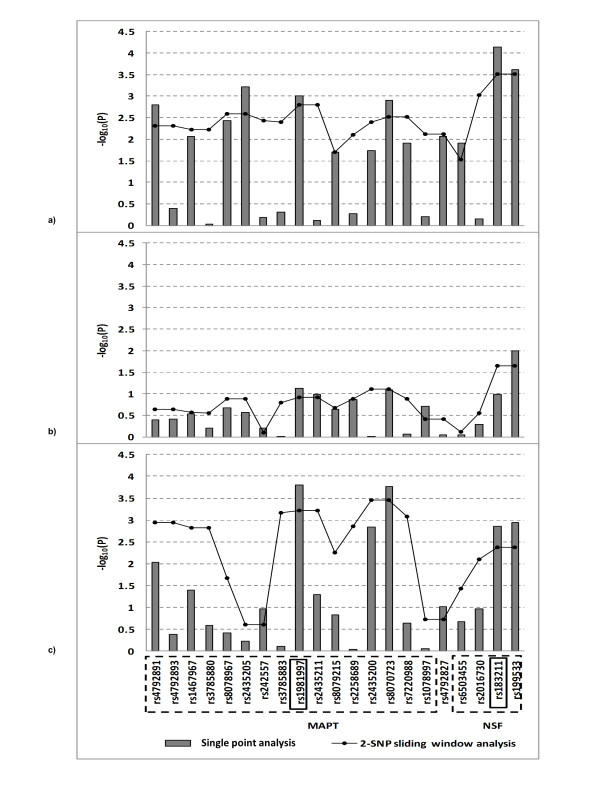
Single point and haplotype analysis of MAPT-NSF region in a) Ashkenazi Jewish, b) NINDS and c) CIDR/Pankratz et al 2009 datasets. 2-SNP sliding window analysis the strongest p-value was present from the exhaustive search.